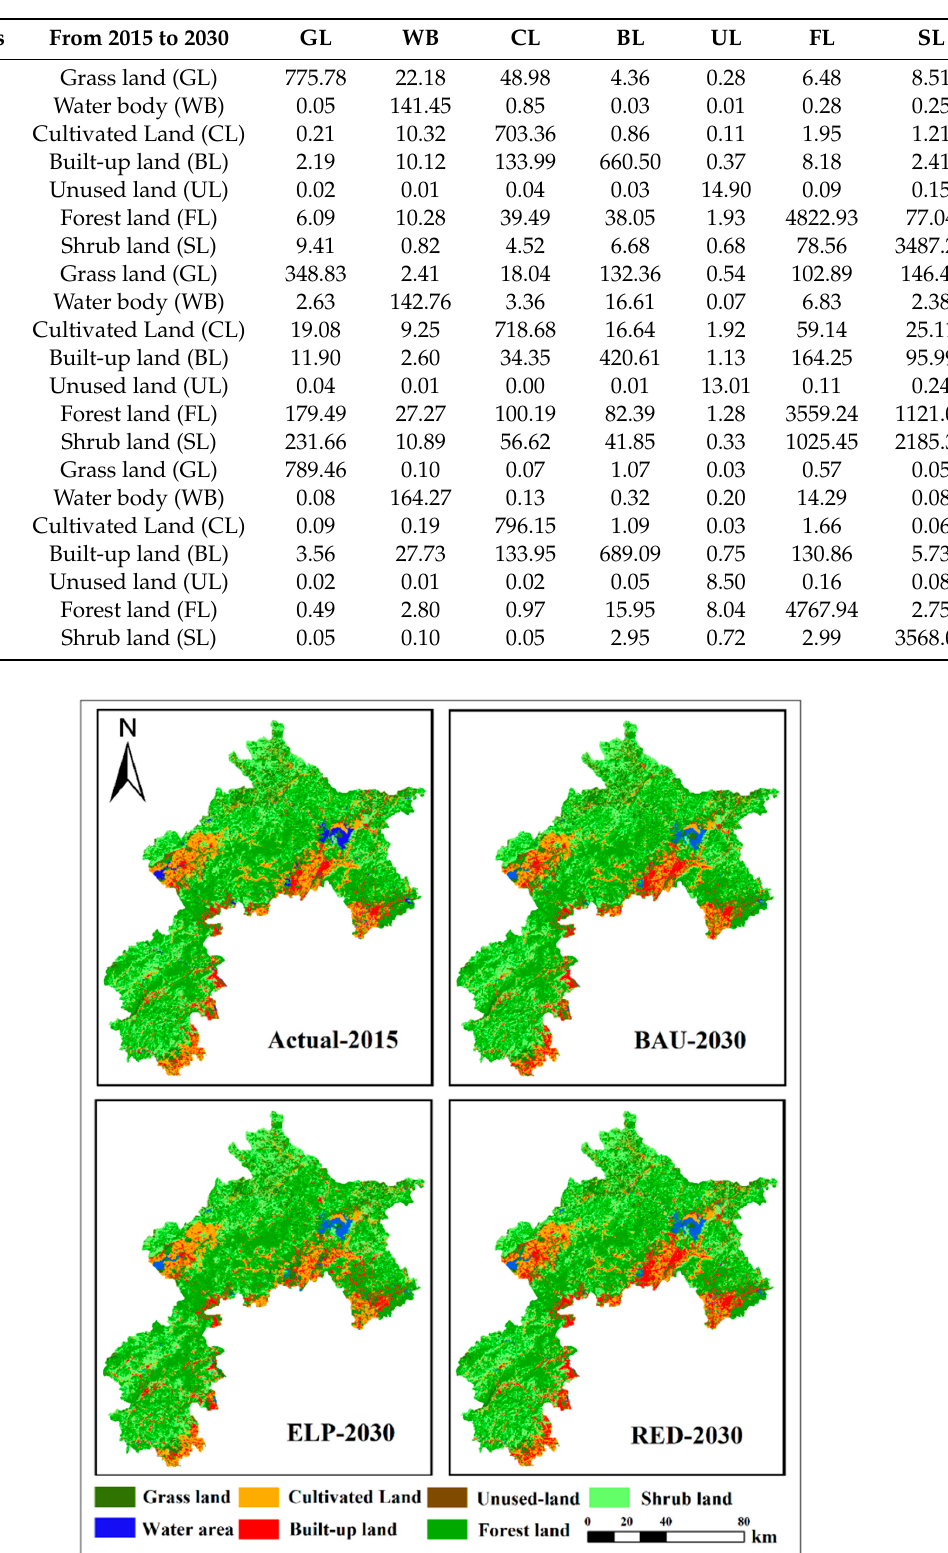
Table 3. Land-use conversion matrix from baseline year 2015 to 2030, under the BAU, RED, and ELP scenarios in the ecological conservation area (km 2 ).